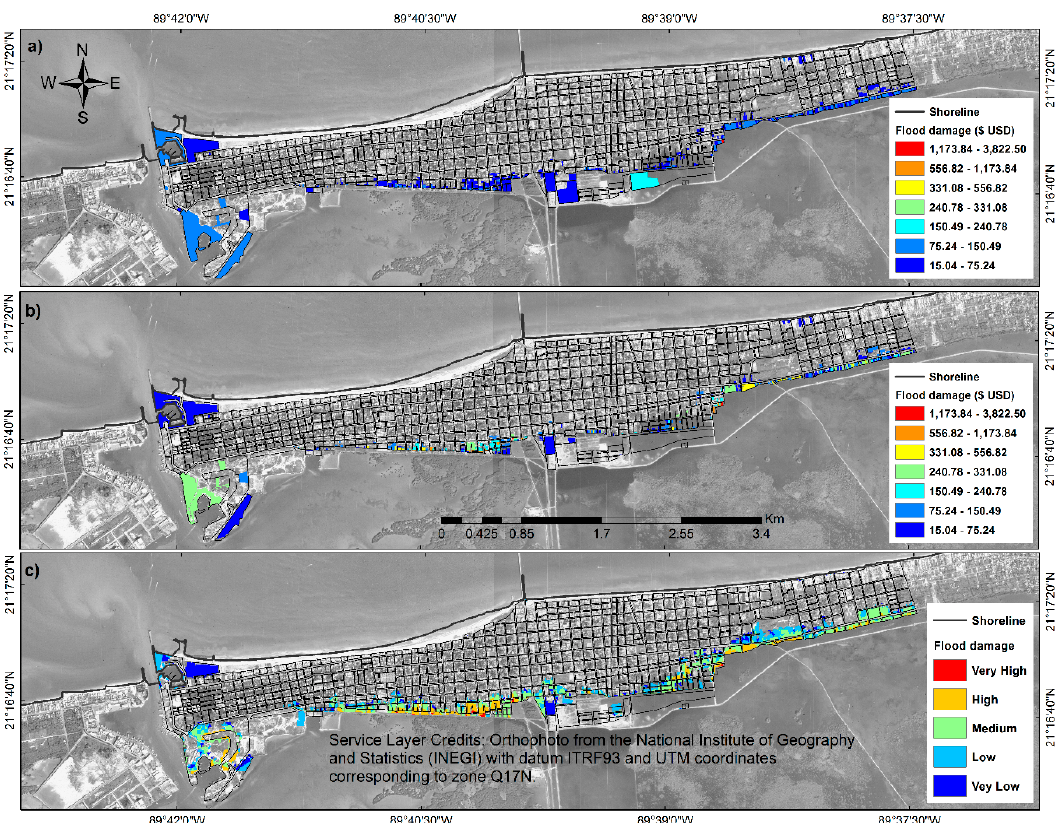
Figure 6. Flood damage for Progreso, Yucatan, using ( a ) CENAPRED_FD, ( b ) CENAPREDv2_FD, and ( c ) FRI_FD methodologies.